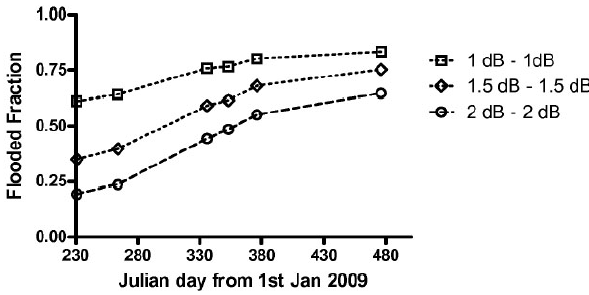
Fig. 8. Fraction of flooded area estimated from ASAR images for six dates and three different